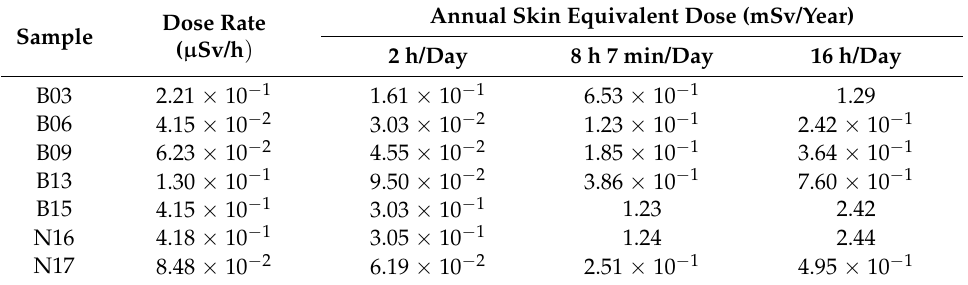
Table 3. Dose rate and annual skin equivalent dose of bracelets and necklaces obtained using the skin dose conversion coefficient.